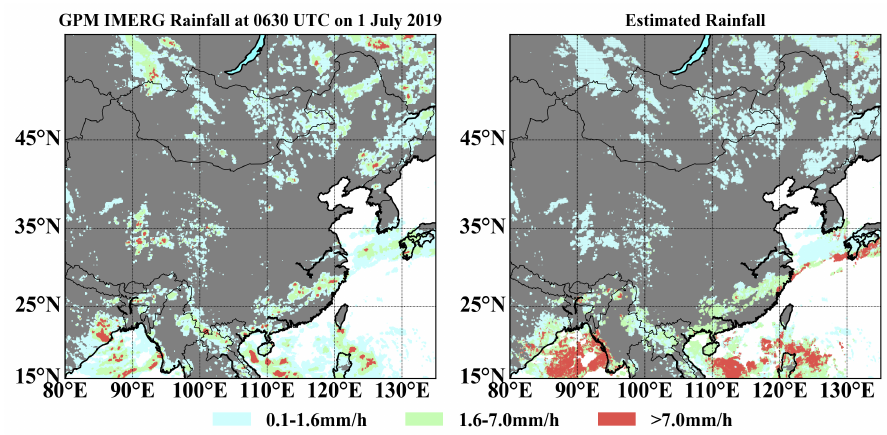
Figure 14. Comparisons of the precipitation grades’ estimation between the GPM ( left ) and RF model ( right ) at 0630 UTC 1 July 2019.